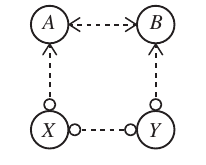
FIG. 11. Remaining class of DAGs after step 2.